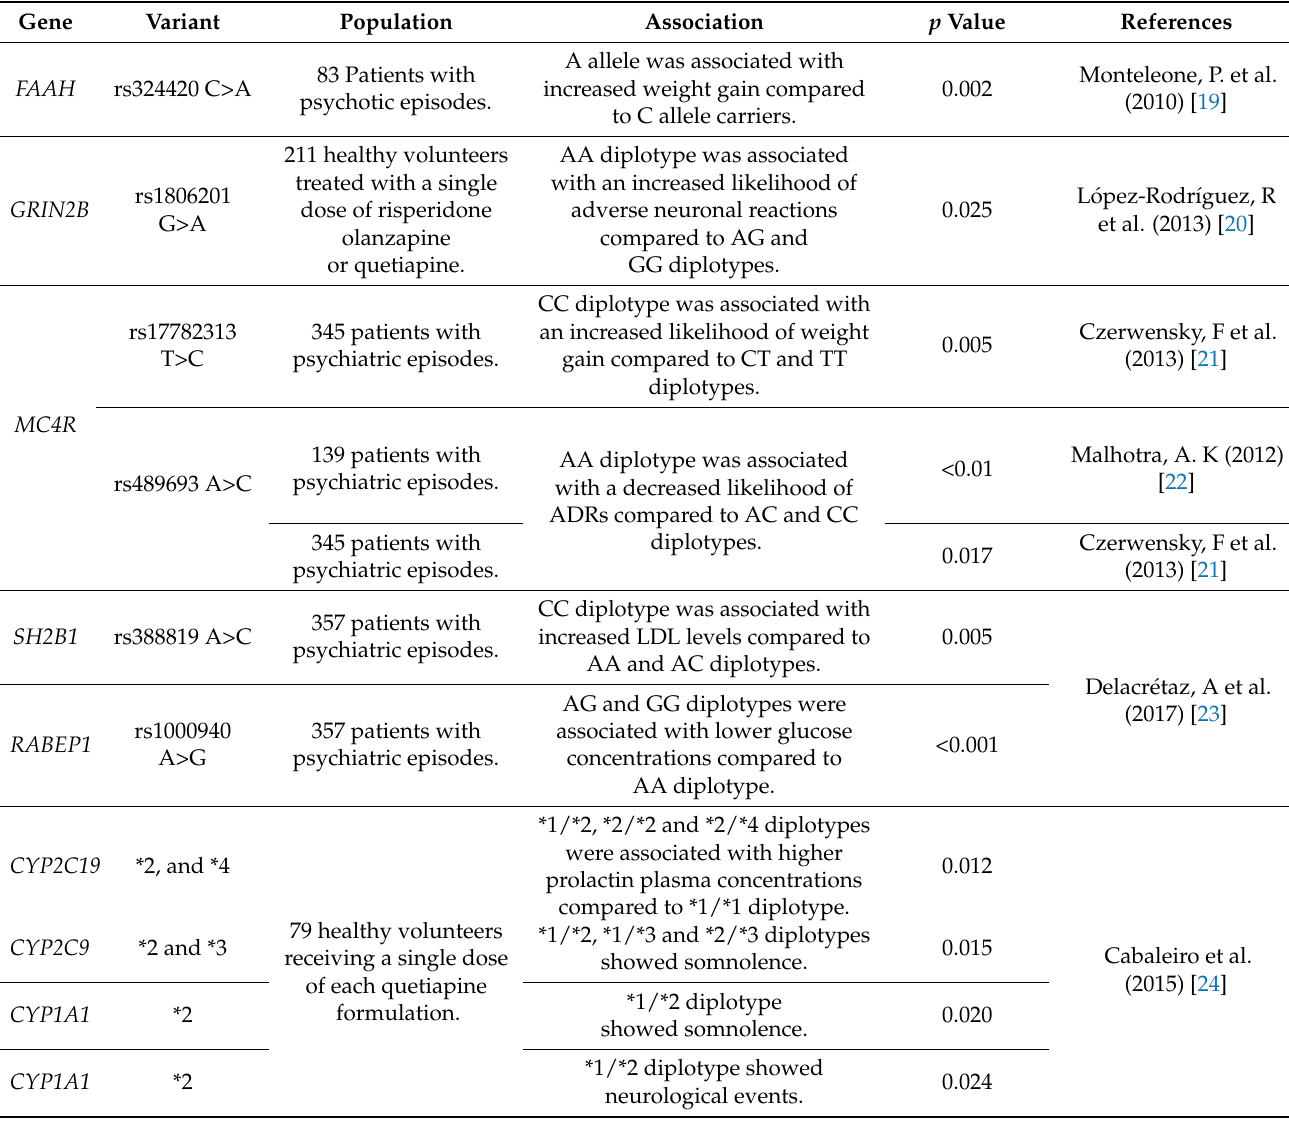
Table 3. Association between gene variants and the adverse reactions of quetiapine [12].